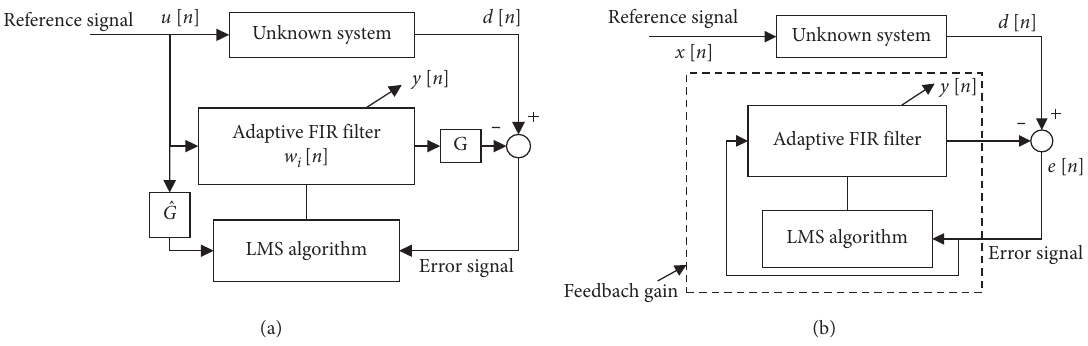
Figure 13: Block diagram of the LMS in the AEM [59]: (a) LMS; (b) modified